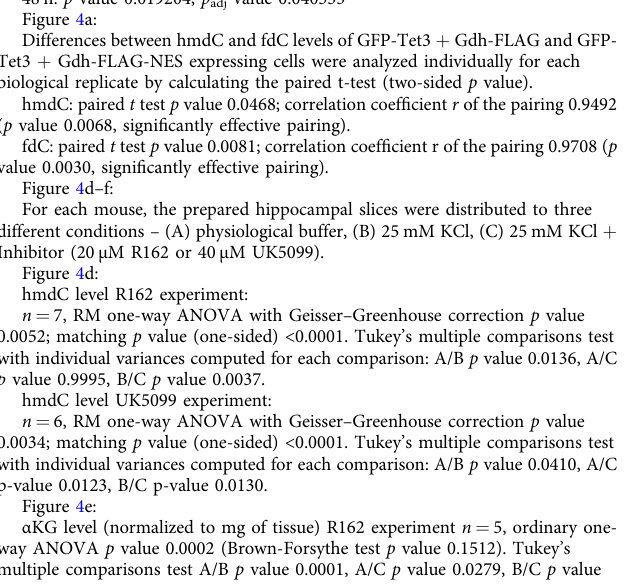
Figure 4e: α KG level (normalized to mg of tissue) R162 experiment n = 5, ordinary one- way ANOVA p value 0.0002 (Brown-Forsythe test p value 0.1512). Tukey ’ s